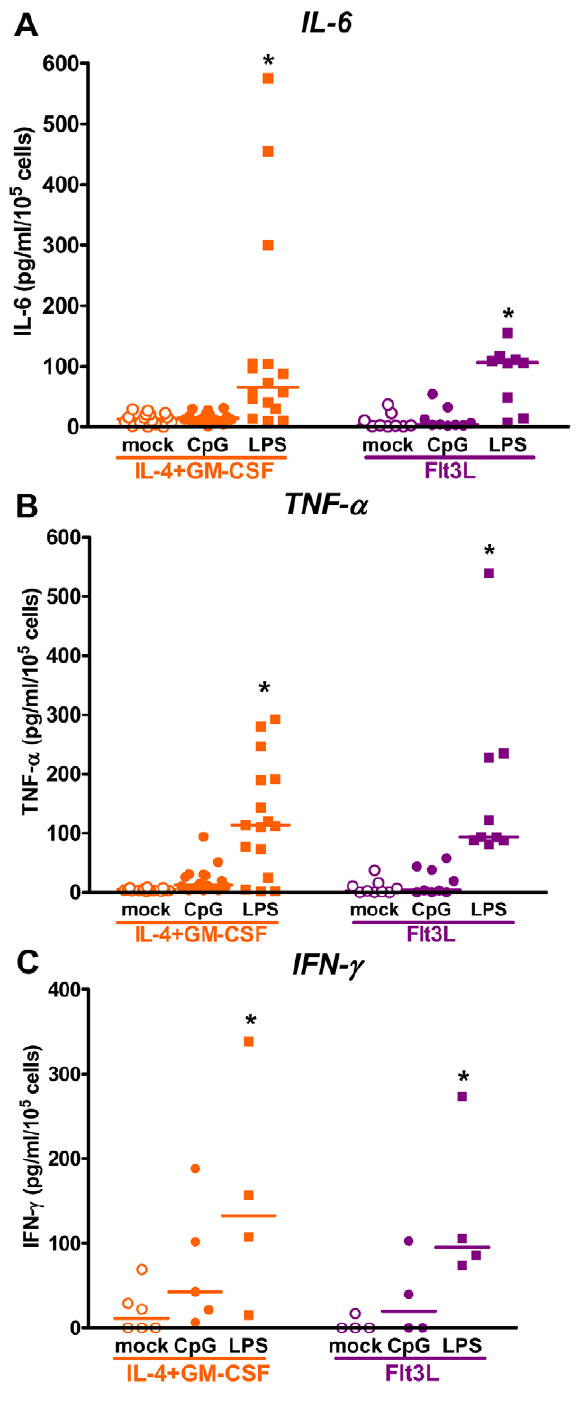
Figure 4. Cytokine release from dog PBDC cultures. Peripheral blood cultures were collected after 7 days in culture with recombinant canine IL-4 and GM-CSF, or Ad.hFlt3L conditioned medium and incubated for additional 24 h without added cytokines in the absence (mock) or presence of CpG 2216 or LPS. Release of IL-6 ( A ), TNF- a ( B ) and IFN- c ( C ) was determined by ELISA. *p , 0.05 vs mock (Two-way ANOVA followed by Tukey’s Multiple Comparison test). Scatter plots show values from individual dog blood cultures